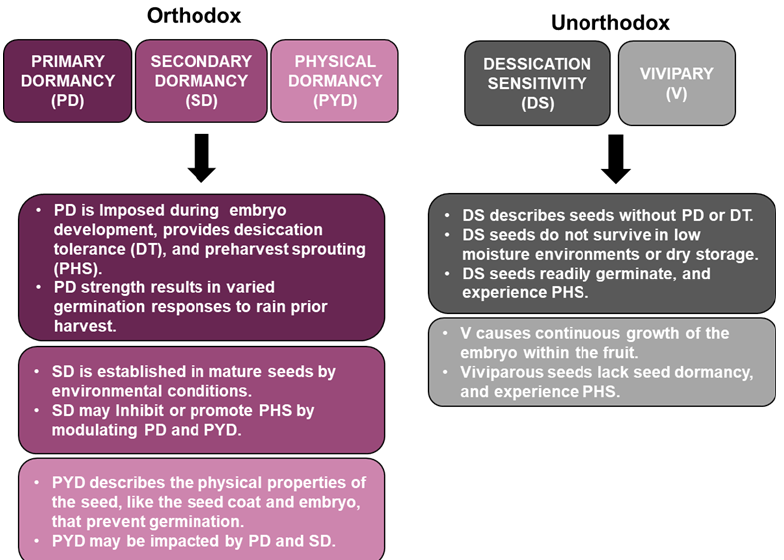
Figure 2. A summary of dormancy types associated with orthodox verses unorthodox seed types. Orthodox seeds display primary dormancy (PD), secondary dormancy (SD), and physical dormancy (PYD). Unorthodox seeds display desiccation sensitivity (DS) and vivipary (V). Specific dormancy programs and changes to these programs have implications for PHS susceptibility or resistance in quinoa.